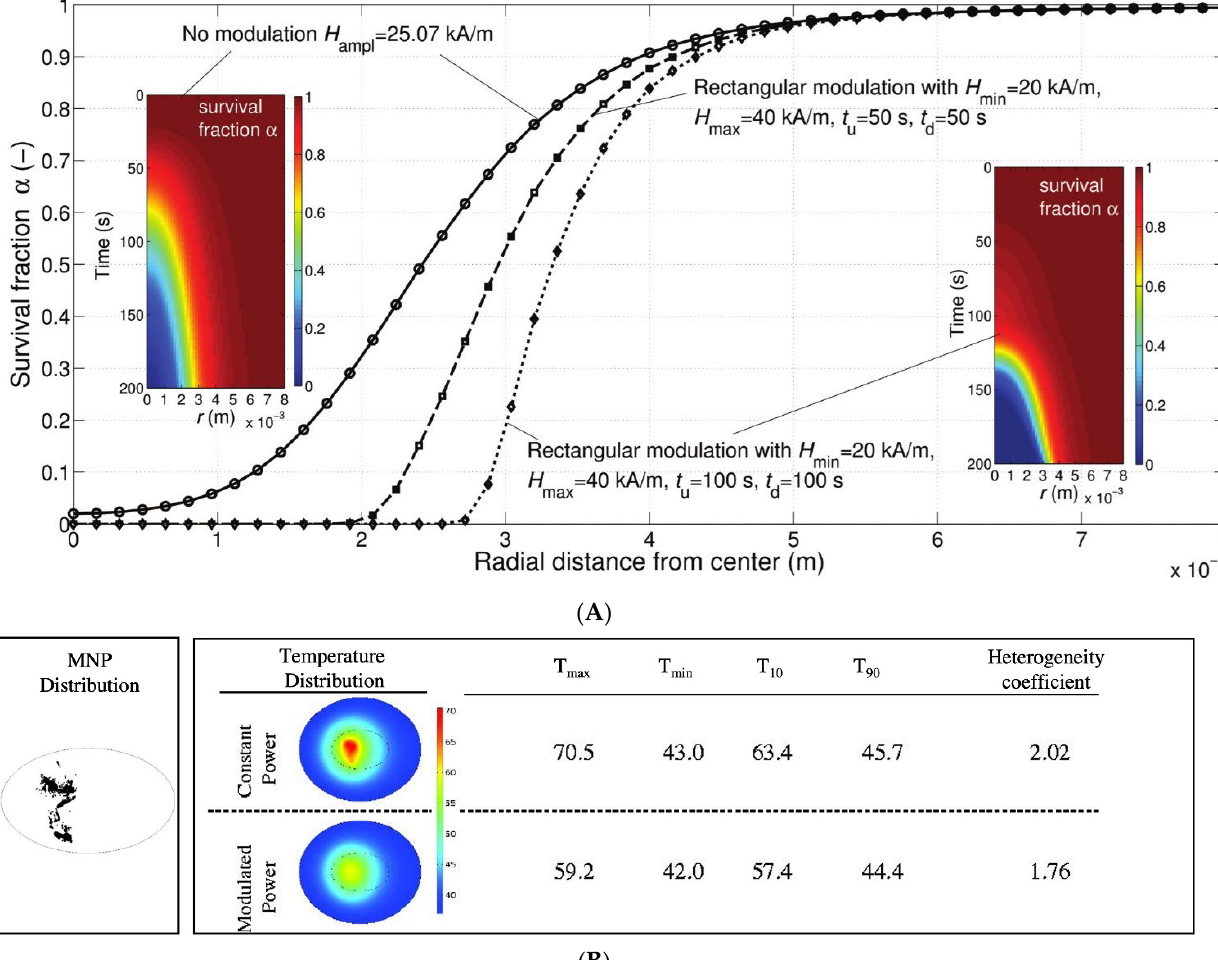
Figure 3. ( A ) Survival fraction ( α ) as a function of radial distance in a 1.24 cm diameter spherical liver tumor and the surrounding parenchyma when AMF is subjected to a rectangular amplitude modulation vs. no modulation. Rectangular modulation results in greater selectivity of the tumor vs. surrounding tissue with regard to thermal damage. The rectangular modulation is assumed to vary between constant AMF minimum H min during time t d and constant AMF maximum H max during time t u . Figure reprinted with permission from [29] cited in text. ( B ) The temperature distributions achieved in liver tumor and healthy tissue after 20 min of heating by constant power vs. power modulation with PID control using temperature feedback at the tumor–healthy tissue boundary in the image-derived MNP distributions. Figure reprinted with permission from [30] cited in text.